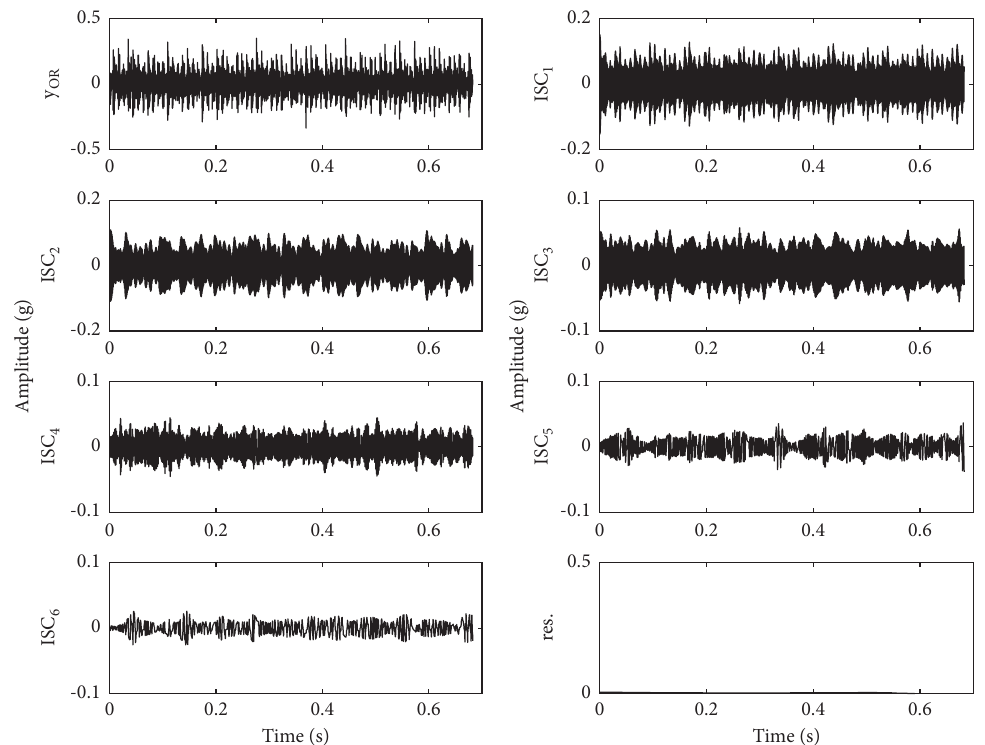
Figure 12: LCD decomposition results of y-channel under outer race fault